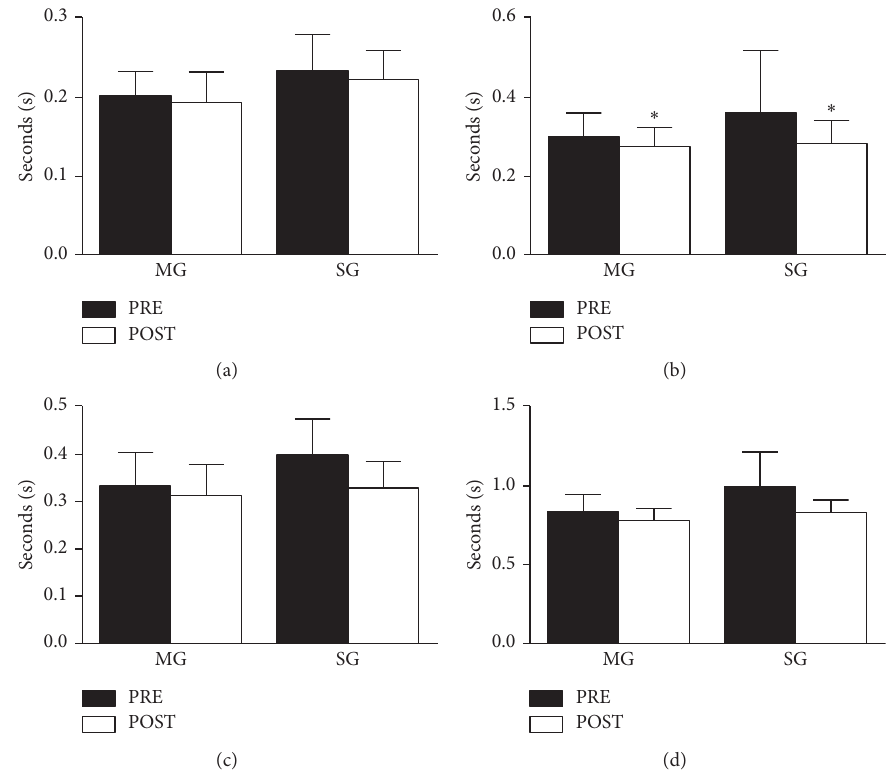
Figure 2: Voluntary step execution test for multicomponent and strength groups at pretraining and posttraining. ∗ Main time effect and p � 0 . 03. (a) Step initiation. (b) Swing phase. (c) Preparation phase. (d) Step total